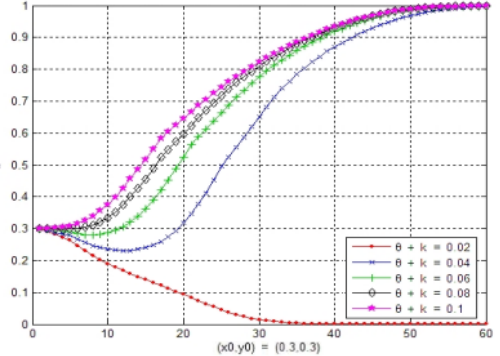
Figure 4. The influence of ( θ + k) change on the probability of government inspections, x.